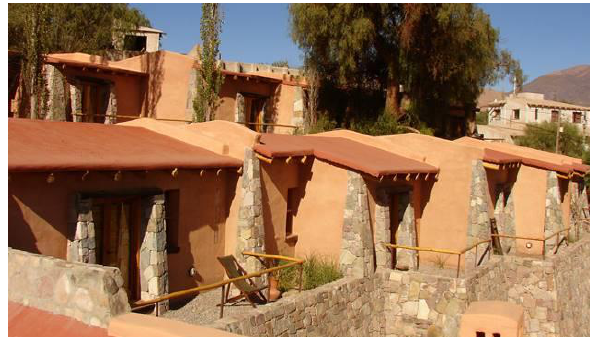
Figure 6. Residence complex in the town of Tilcara © Authors.